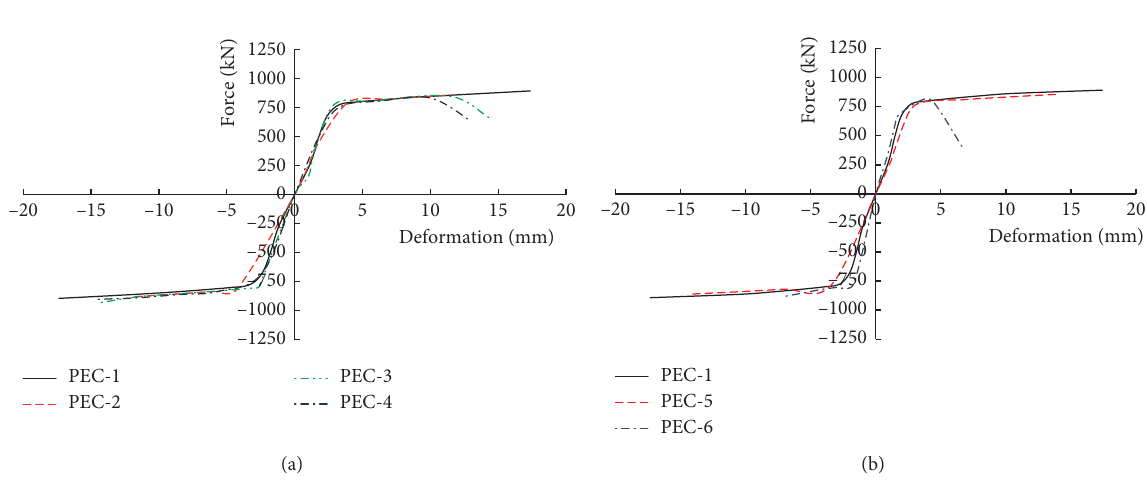
Figure 9: Backbone curves of the models. (a) PEC-1, PEC-2, PEC-3, and PEC-4. (b) PEC-1, PEC-5, and